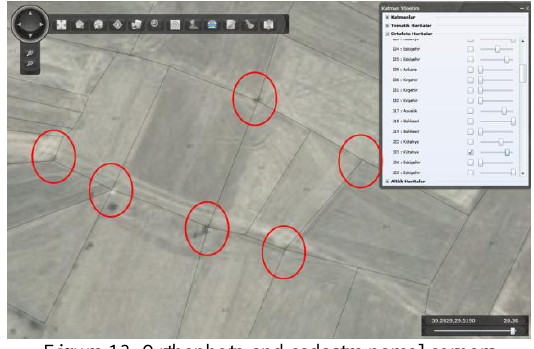
Figure 13. Orthophoto and cadastre parcel corners Production of the size of the pixels may be 1-1.5 ortofotolarda position accuracies (Figure 13).